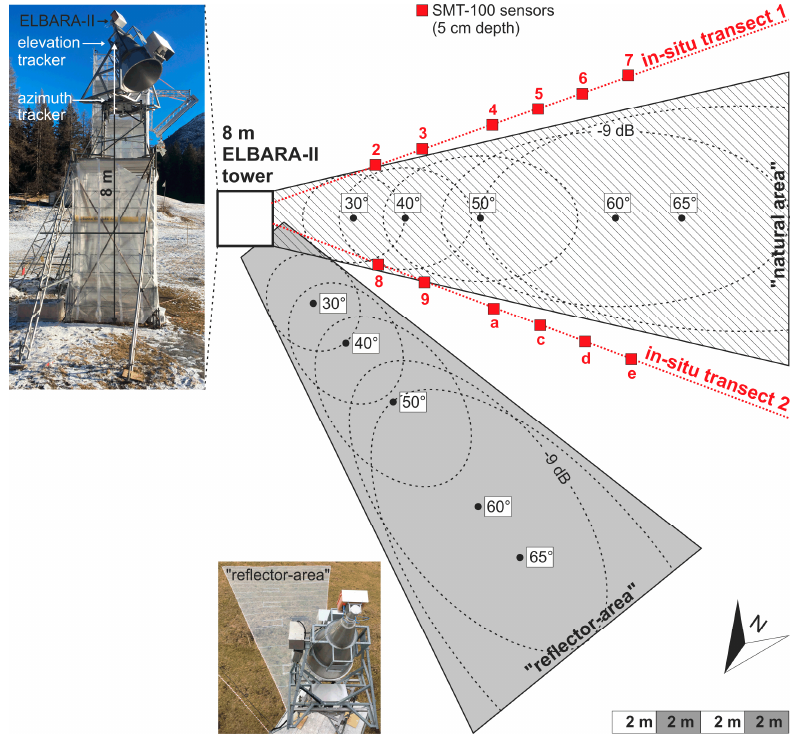
Figure 1. Schematics of the Davos-Laret Remote Sensing Field Laboratory [22] during the winter 2016/17 campaign.